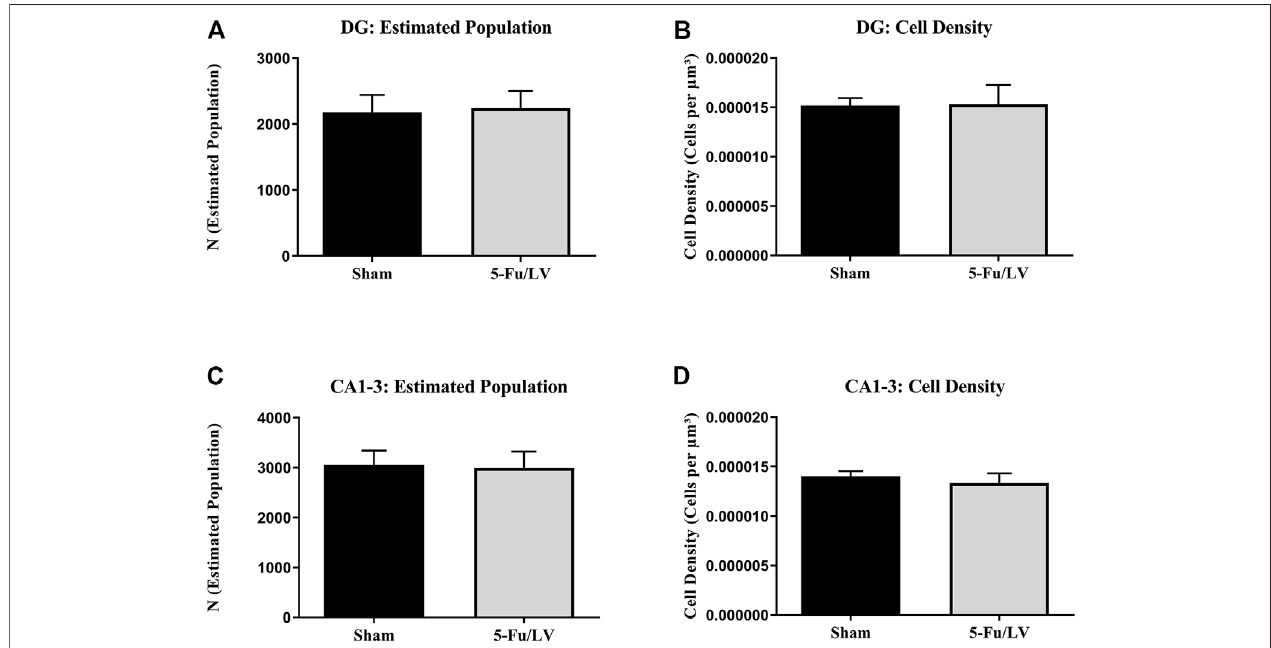
FIGURE6| 5-Fu/LV treatment does notaffect activated microglia activation. TheanalysisofCD68-labeled cellsrevealednosigni fi cantdifferencesincell densityor estimated cell number in DG [Fig. (A) and (B) ] and CA 1 – 3 areas [Fig. (C) and (D) ].